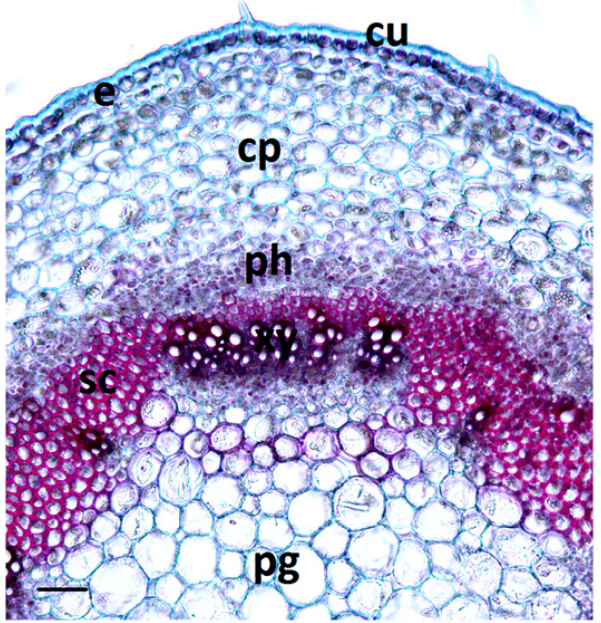
Fig. 5. Cross section of stem of Matthiola anchoniifolia : (cp- cortex parenchyma; cu- cuticle; e- epidermis; pg- pith region; sc- sclerenchyma (Scale bar: 100 μm)